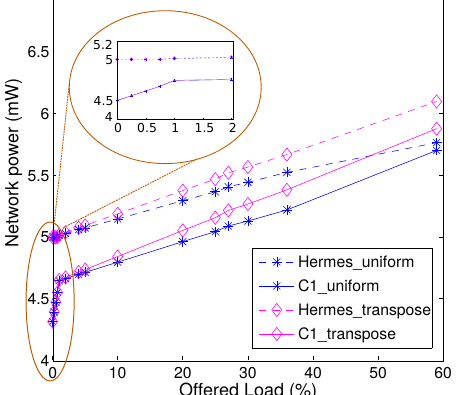
Figure 15. Network-level power consumption